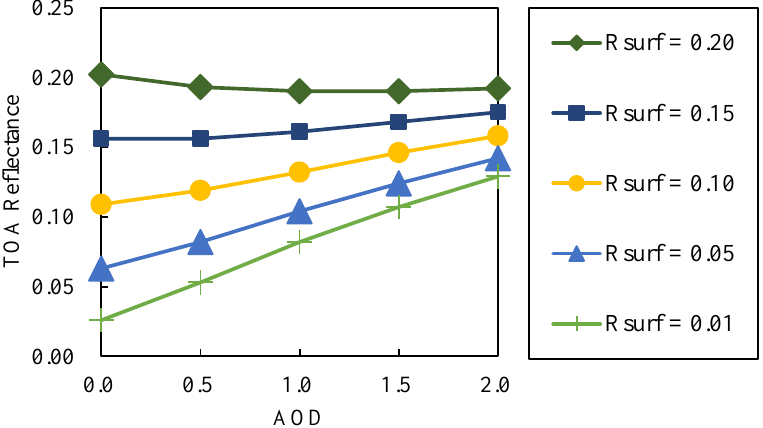
Figure 6. TOA reflectance as a function of AOD and surface reflectance at 0.67 μm. Simulation is performed under the observation geometric conditions with solar zenith angle = 45°, satellite zenith angle = 2° and relative azimuth angles = 45°.